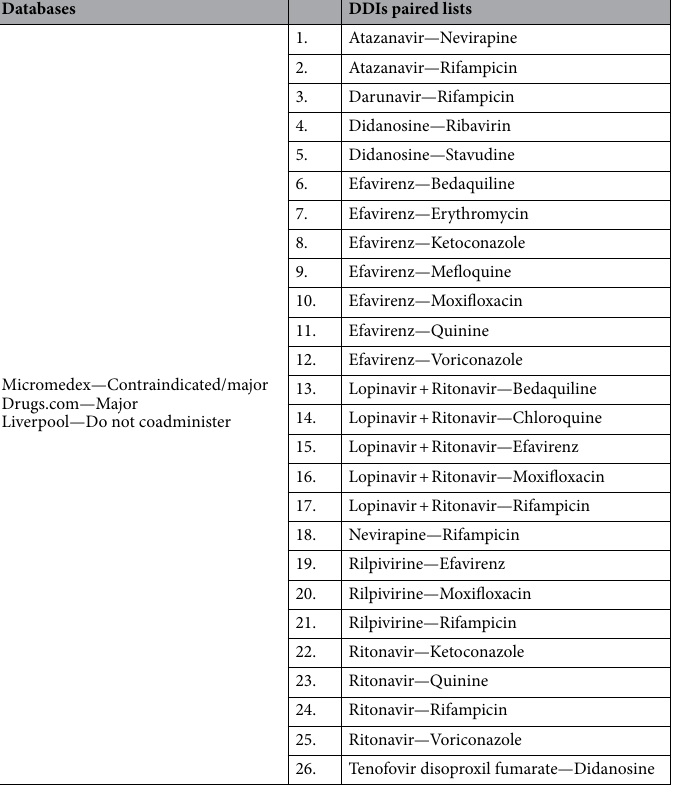
Table 2. Drug pairs for which there is a good concordance in DDI severity grading across databases (contraindicate or major by three database).